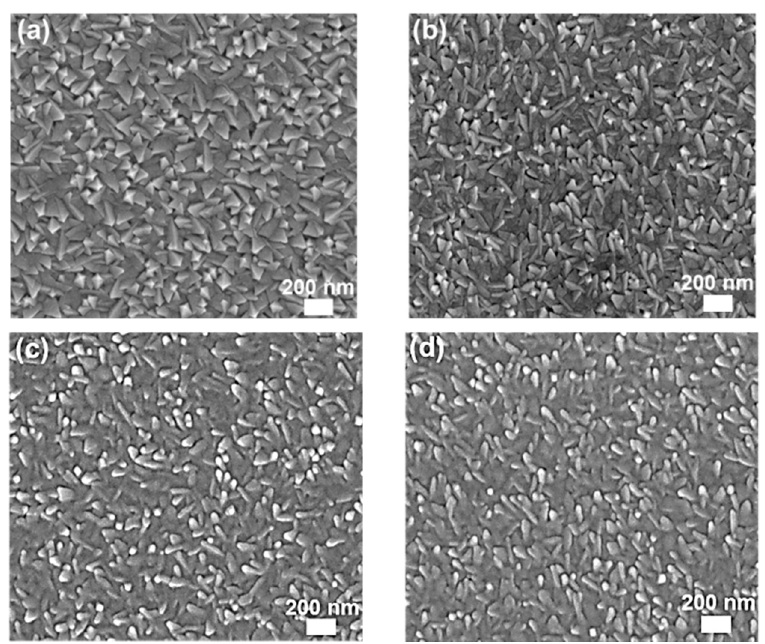
Figure 2. Surface FE-SEM pictures of ( a ) and ( b ) the as-deposited Y 2 O 3 films before and after fluorocarbon plasma etching, respectively, and ( c ) and ( d ) the SF 6 plasma-treated films before and after fluorocarbon plasma etching, respectively.